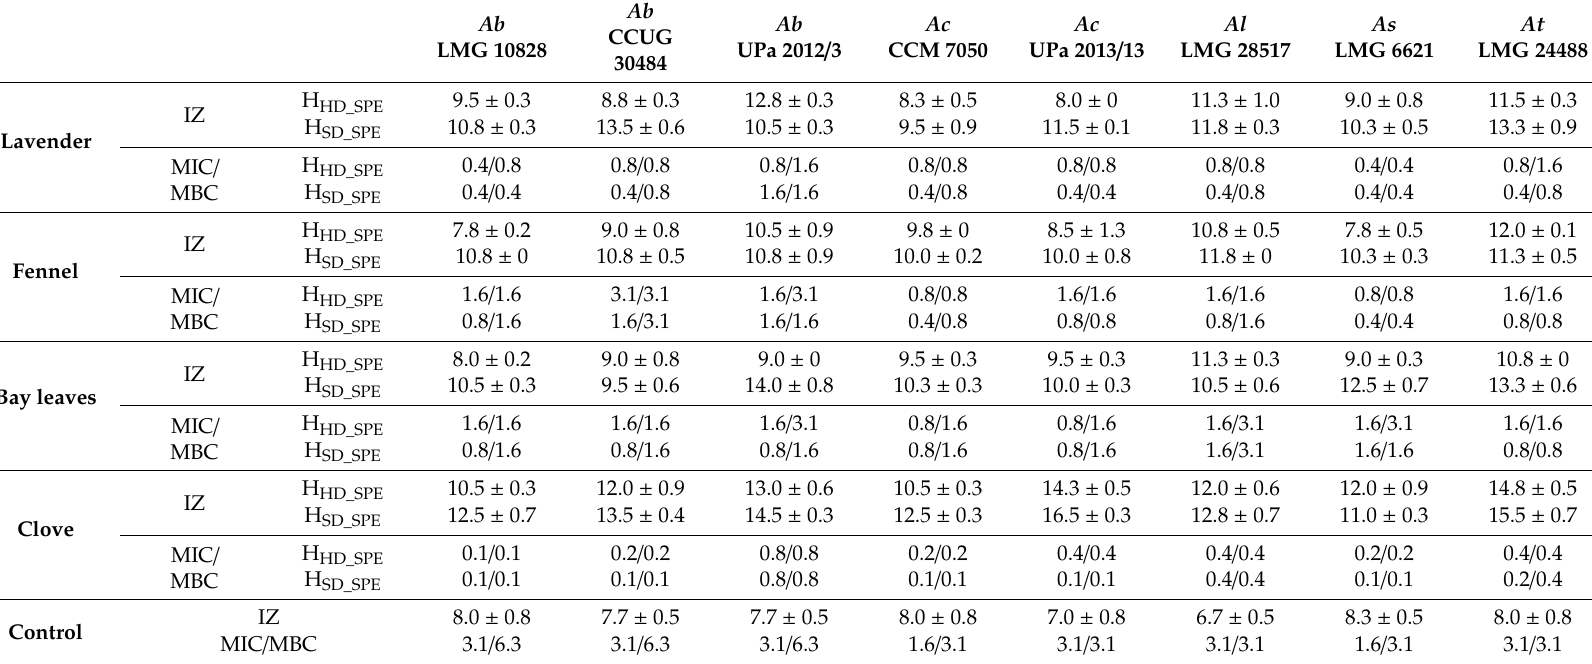
Table 6. Antimicrobial activity of hydrolates concentrated by SPE on Arcobacter -like strains—mean inhibition zones in mm (including disc 6 mm in diameter) ± standard deviation and minimal inhibitory / bactericidal concentrations in %, n =